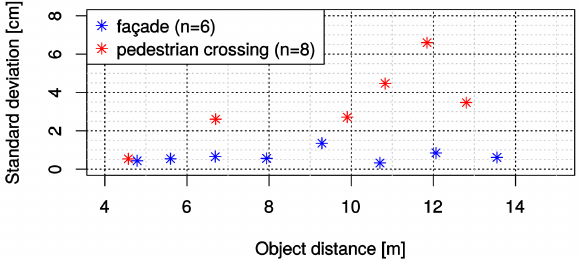
Figure 8. Accuracy of 3D distances depending on